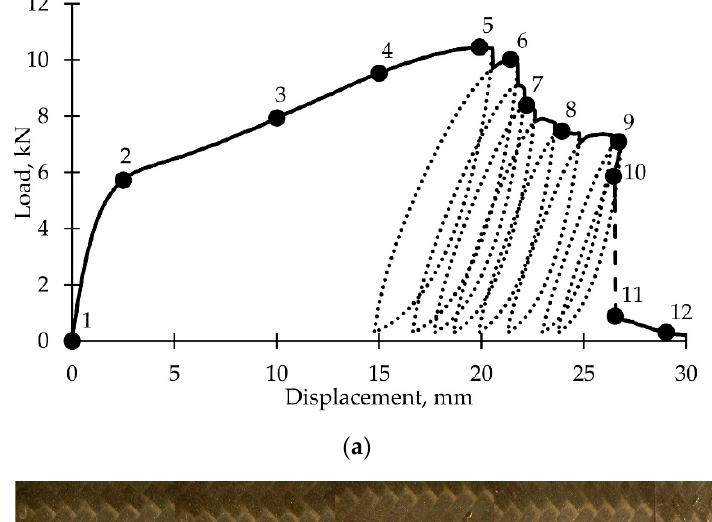
( b ) Figure 11. Loading diagrams with additional torsion vibrations: ( a ) Experimental data; ( b ) compar- ison between postcritical stage during active loading and loading with additional vibrations. 3.3.2. Analysis of Acoustic Emission Signals Dependence of the AE signal energy on displacement is shown in Figure 12a. A burst of AE energy was noted during the transition from elastic deformation to linear harden- ing. Results are similar to those described in Section 3.1.4. Distribution diagram of the AE signal frequencies versus displacement is shown in Figure 12b. AE signals are also grouped into the three ranges described earlier in Sections 3.1.4. and 3.2.4. There is an almost complete absence of AE signals in 190–240 kHz